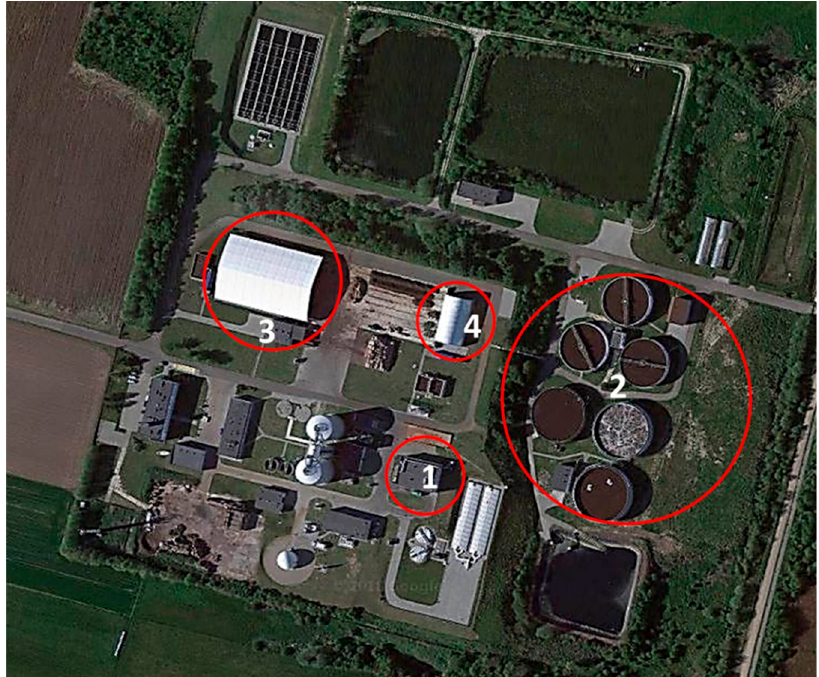
Figure 1. Measurement locations at WWTP; 1—hall of mechanical treatment (HMT), 2—biological reactors area (BRA), 3—sludge composting piles (SCP), 4—solid waste composting piles (SWCP).